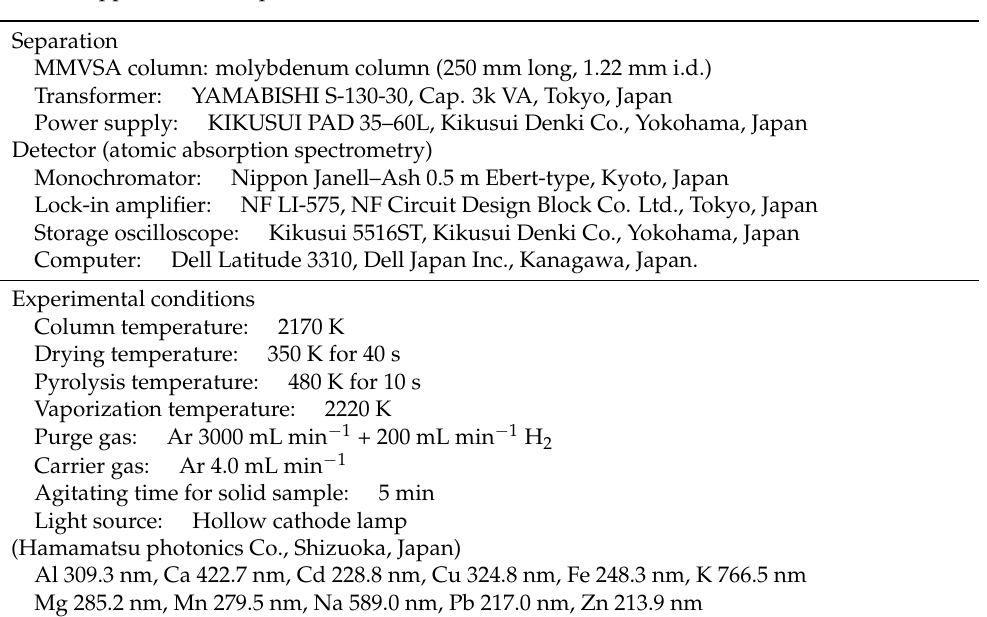
Table 1. Apparatus and experimental conditions for MMVSA